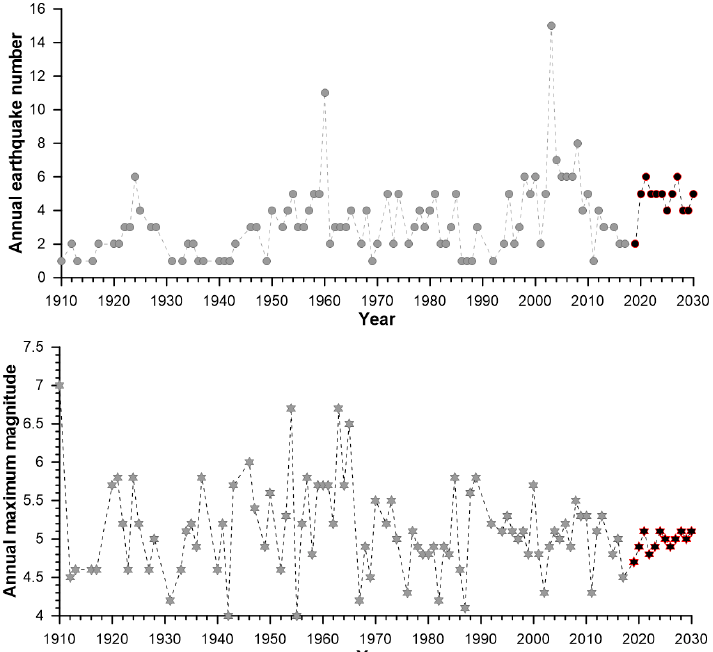
Figure 10. Observed and forecasted (in red) values for the number of earthquakes (top) and the annual maximum magnitude (bottom) using the SSA model.